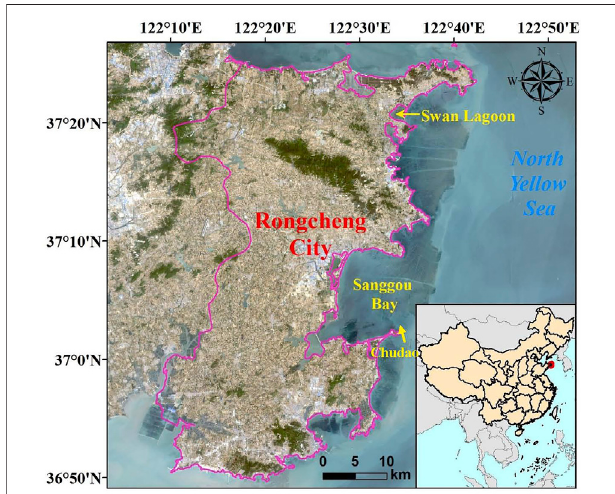
FIGURE 1 | Location of Rongcheng city on the coast of